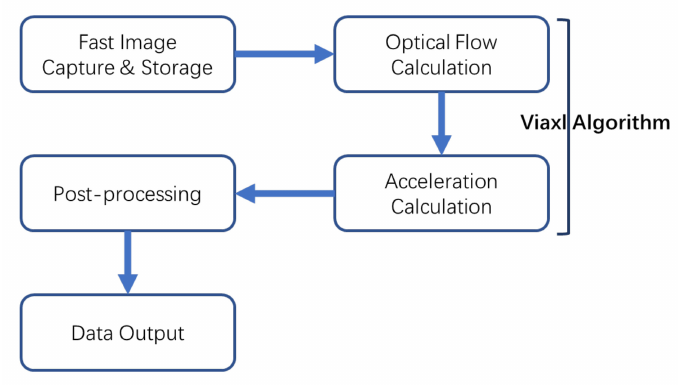
Figure 2. The workflow of